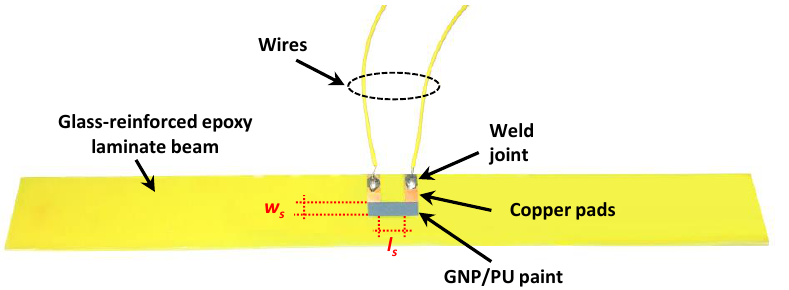
Figure 4. GNP/PU paint ( w s = 5 mm; l s = 8 mm) deposited between two copper pads on a FR4 beam for electromechanical tests.